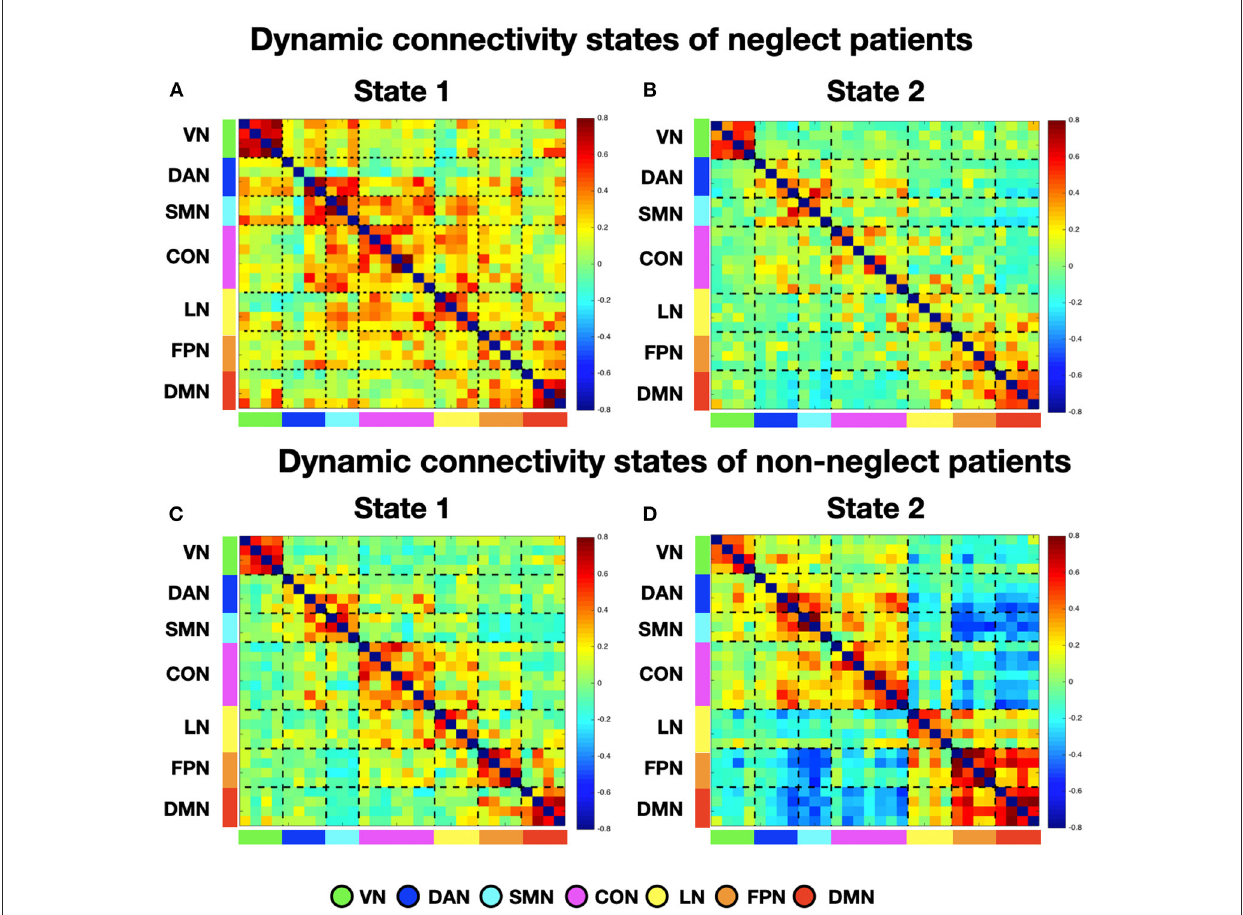
FIGURE4 Dynamic connectivity states of neglect and non-neglect patients. (A, B) Display the centroid of the functional network connectivity states identified in the sub-cohort of neglect patients, whereas (C, D) indicate those of non-neglect patients. Color bar and abbreviations as in Figure 1.